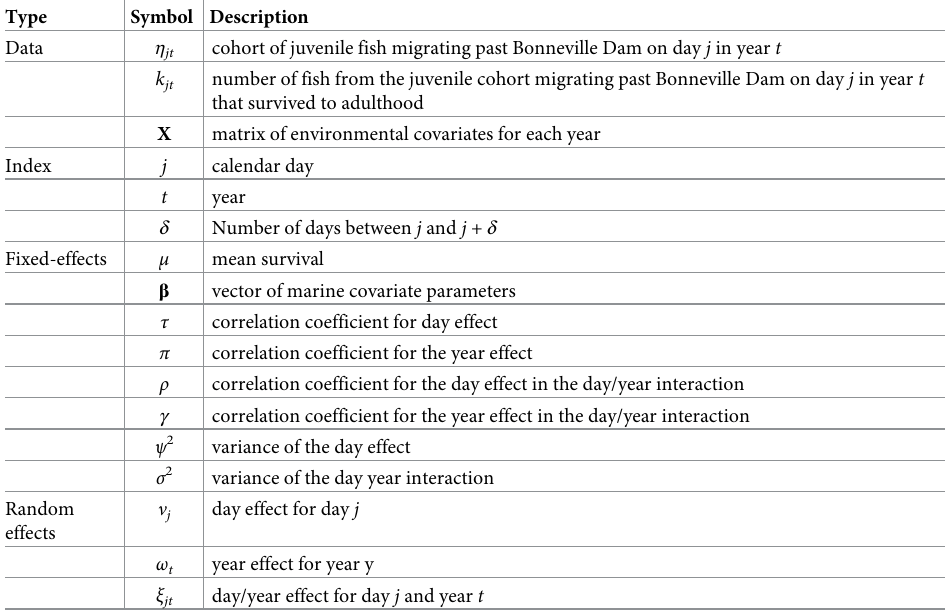
List of data types, subscripts, parameters (i.e., fixed effects), and random effects used to model the smolt to adult survival of spring/summer Chinook salmon originating from the Snake River